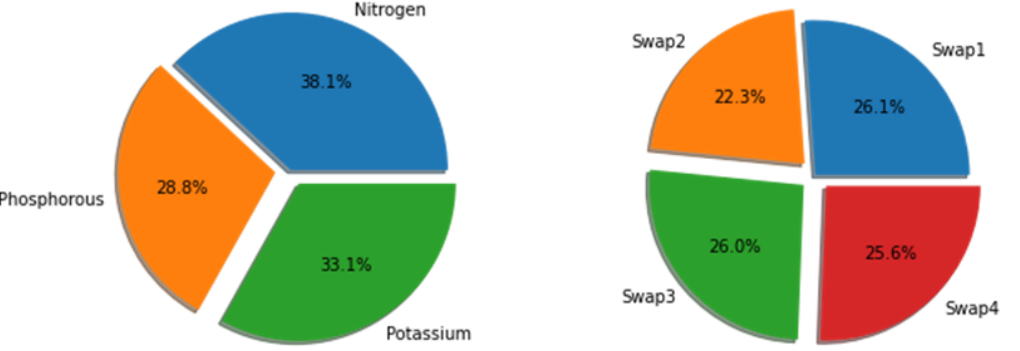
Figure 3. Types of techniques used for nutrient deficiency classification in crops (in previous stud- ies).